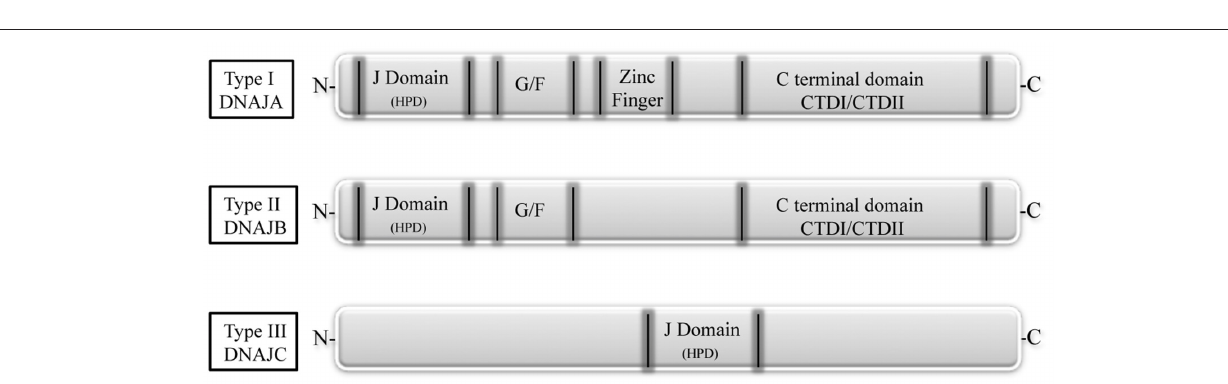
FIGURE 2 | The DNAJ protein family. Based on their structure, DNAJs are divided into three subtypes. Type I, or A, has an N-terminal J domain (with a conserved histidine, proline, and aspartic acid tripeptide), followed by a glycine/phenylalanine-rich domain (G/F), by a zinc finger region rich in cysteine, and by a C-terminal domain, responsible for client binding and presenting two barrel domains, CTDI and CDTII. Type II, or B, is similar to type I, but lacks the zinc finger region. Type III, or C, has only the conserved J domain which is variably located in the protein (Fan et al.,